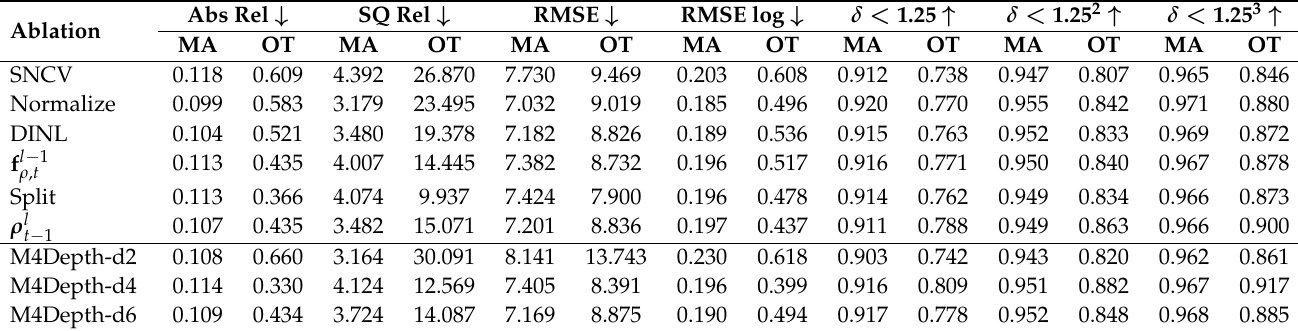
Table 6. Performance of M4Depth (trained on Mid-Air, averaged over 4 runs) for various architecture depths and ablations (on a network with 6 levels), and for a full architecture with 2, 4, and 6 levels, when tested on Mid-Air (MA) as well as in generalization on the old town scene (OT) of TartanAir. The four first metrics need to be minimized ( ↓ ) and the three last ones need to be maximized ( ↑